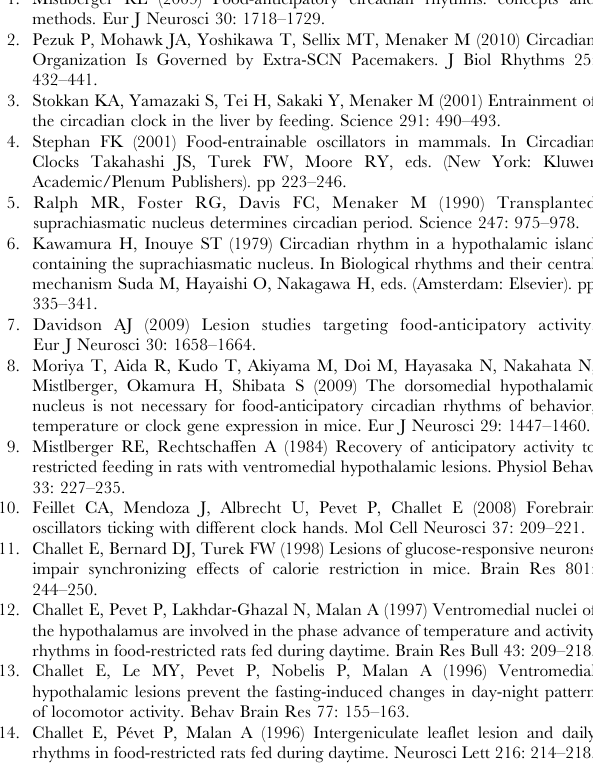
Figure S1 Reduced food reward affects body tempera- ture patterns. Body temperature patterns of two representative animals with gradually reduced food reward ( A , B ) and an ad libitum control animal ( C ). Body temperature occurring during the rest phase is reduced, eventually leading to torpor. Data are from the same animals as presented in Fig. 1 (panel identifiers correspond). (TIF) Figure S2 Reduced food reward shifts activity rhythms before torpor occurs. This example shows that some animals in the experiment presented in Fig. 2 and Fig. S1 clearly showed a shifted activity rhythm well before torpor occurs. The opposite (torpor occurs before the activity rhythm is shifted) was never observed. These data indicate that torpor is not necessary to shift the activity rhythms into the day. It is rather the shifted activity rhythms that allow torpor to occur in the dark phase.